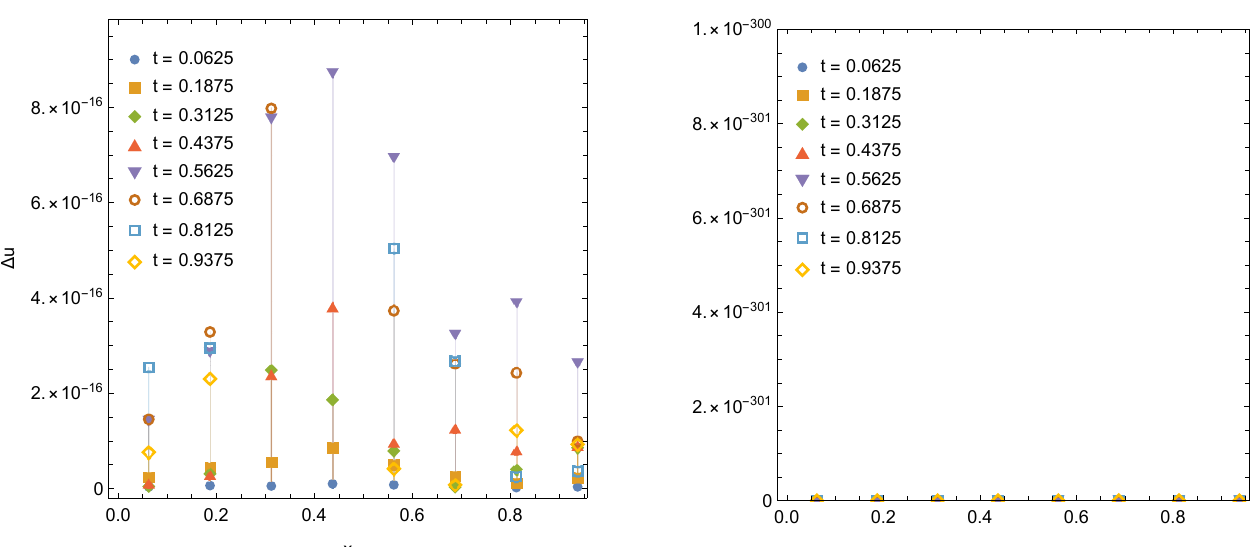
Figure 8. The absolute error computed for Example 5 given that M = 8, µ = 1, α = 3 / 2 with machine precision ( left sub-figure) and with double precision ( right